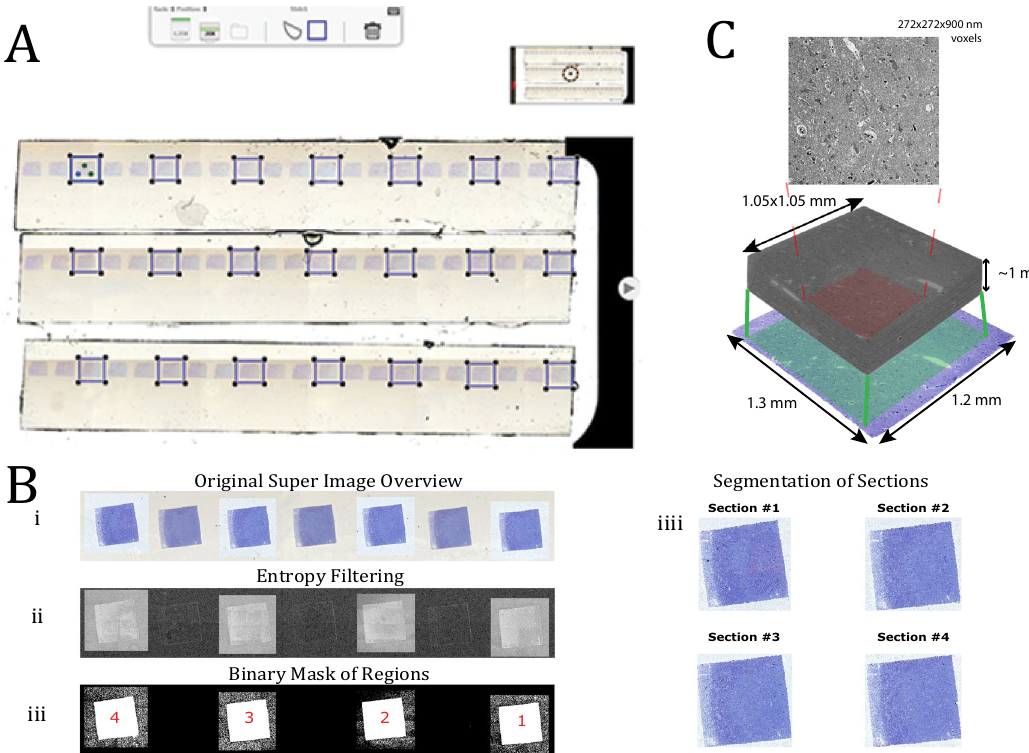
Fig. 3 Image acquisition and 3D-stacks of aligned sections. A Overview of a microscopic glass slide with the commercial Leica software. Systematic sampling of every third section was manually marked with three local points for the autofocus calibration. B In MATLAB, a TIF image was loaded where each second was of interest, which is different from ( A ) but easier to visualize as an example (i). Next, we used an entropy fi lter to detect sections of interest (ii). Binary masks have been computed for each section of interest and the images are ready for export (iii). The output of each exported section (iv). C Individual sections were aligned and stacked on top of each other. The stacked block of sections was then cropped down to a speci fi c ROI (1.05 × 1.05 mm ) which only contains